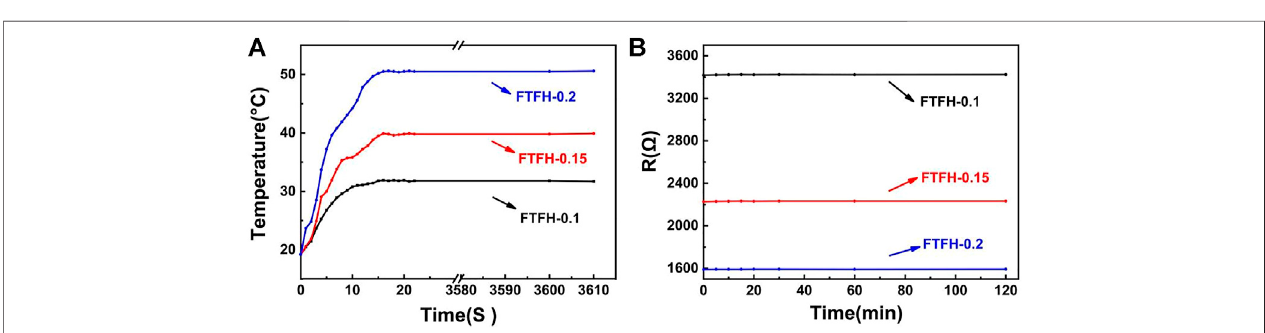
FIGURE 7 | (A) The generated temperature-responsetime of the FTFH with the various carbon nanotubes content. (B) The resistance-response time of the FTFH with various carbon nanotubes content.